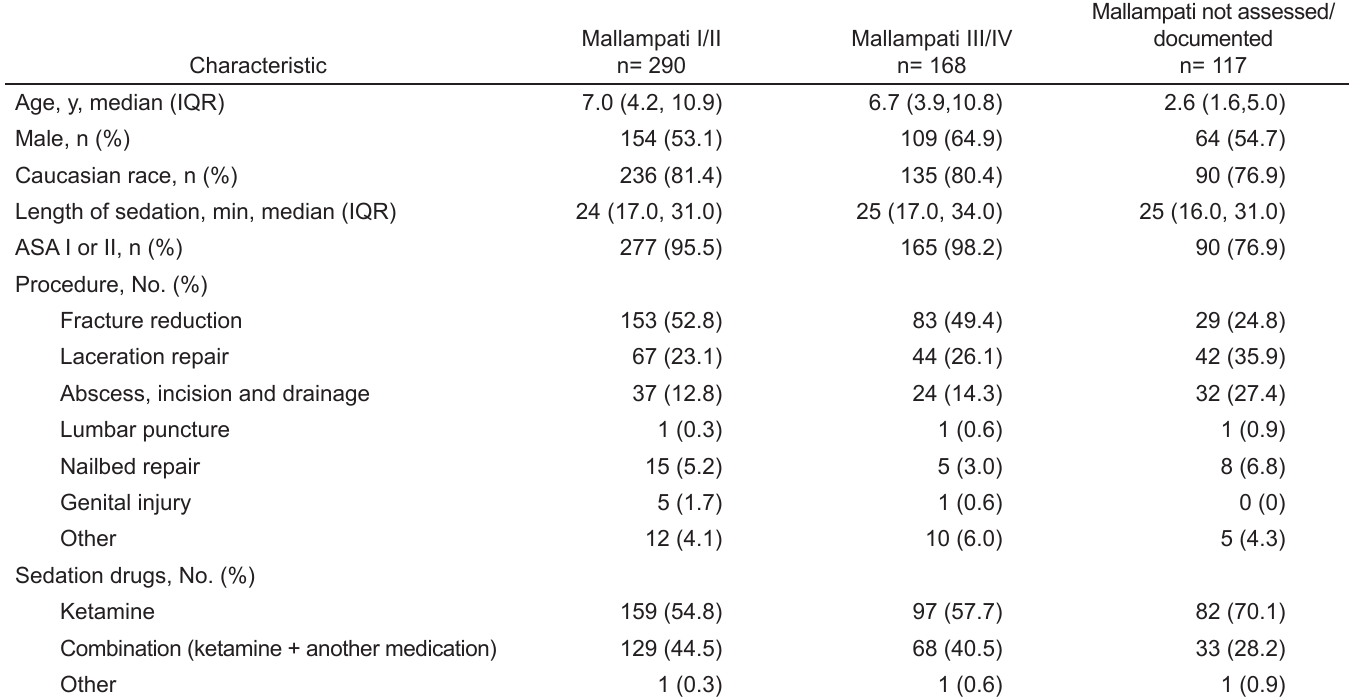
Table 1. Characteristics of the patients undergoing procedural sedation and analgesia, with Mallampati score.